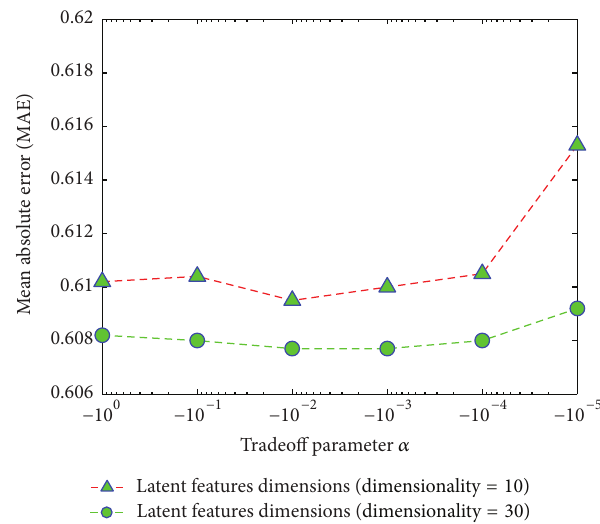
Figure 9: Impact of tradeoff parameter 𝛼 with different dimensions of latent features.